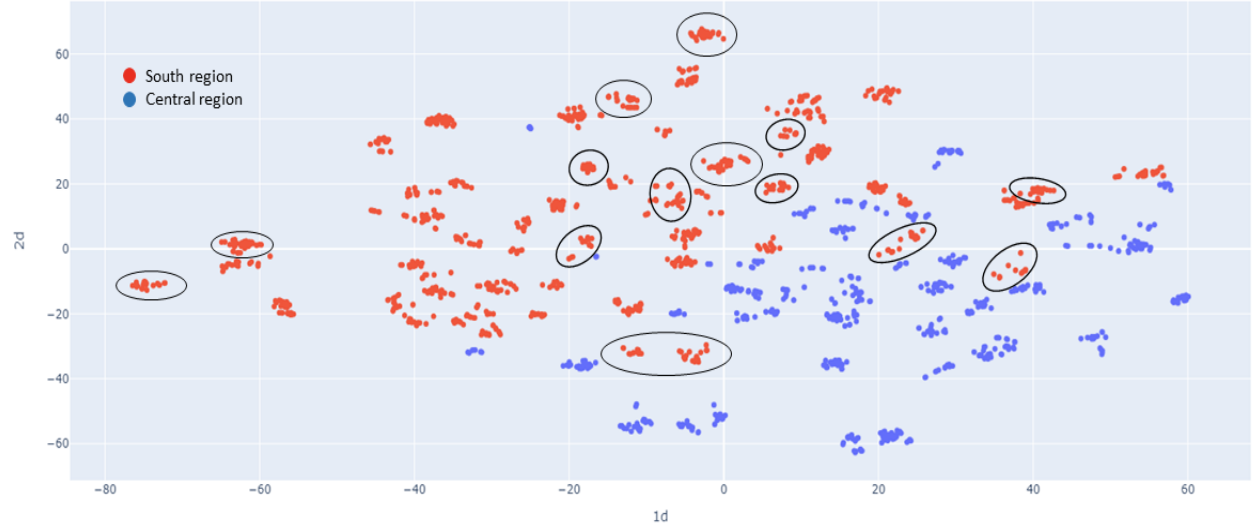
Figure 4. Clustering analysis by t-SNE based on morphological traits of trees, fruits and seeds in South and Central regions (red and blue colour). Ebolowa geographical population is marked by black ellipses.